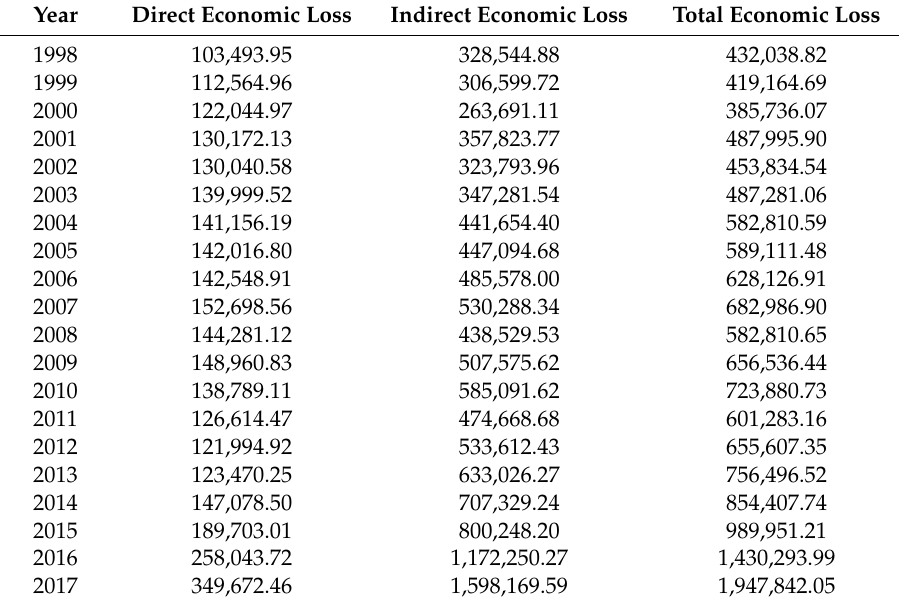
Table A3. Economic losses from disease in mainland China from 1998 to 2017 / 10 4 CNY.